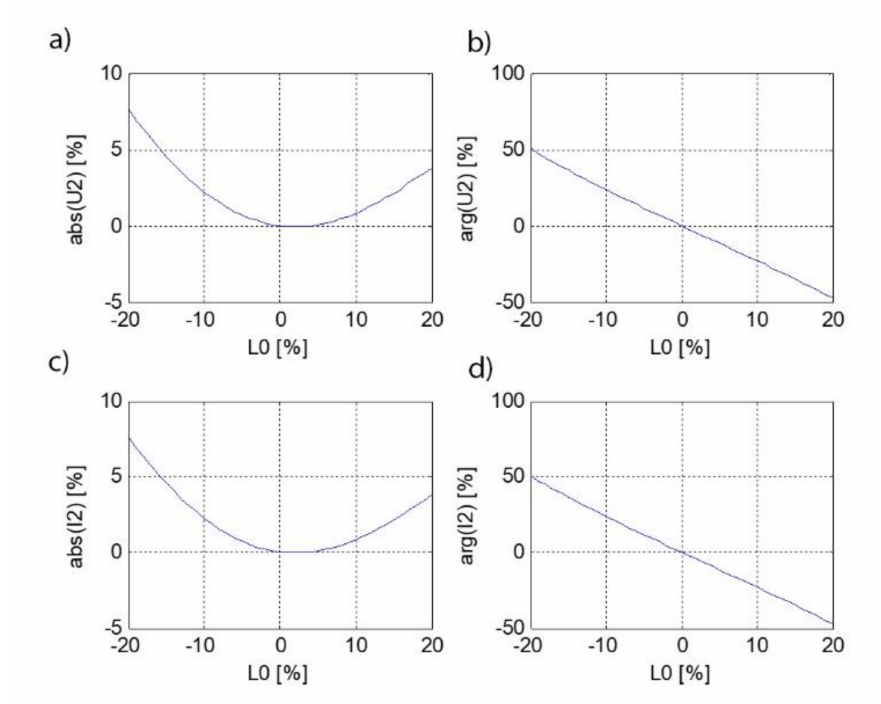
Figure 19. Changes of wave parameters depending on L 0 at f = 1 MHz; ( a ) U 2 voltage modulus, ( b ) U 2 argument, ( c ) I 2 modulus, ( d ) I 2 argument. Changes of the U 2 voltage modulus occur when parameter C 0 is changed non − linearly, and change from − 14% to 8% independently of frequency. (Figures 20a, 21a and 22a). The U 2 argument falls almost linearly from 50% to − 50%, independently of frequency (Figures 20b, 21b and 22b). The I 2 modulus changes from − 14% to 8%, independently of the frequency (Figures 20c, 21c and 22c). The I 2 argument decreases linearly in the range from 50% to − 50%, independently of the frequency (Figures 20d, 21d and 22d).